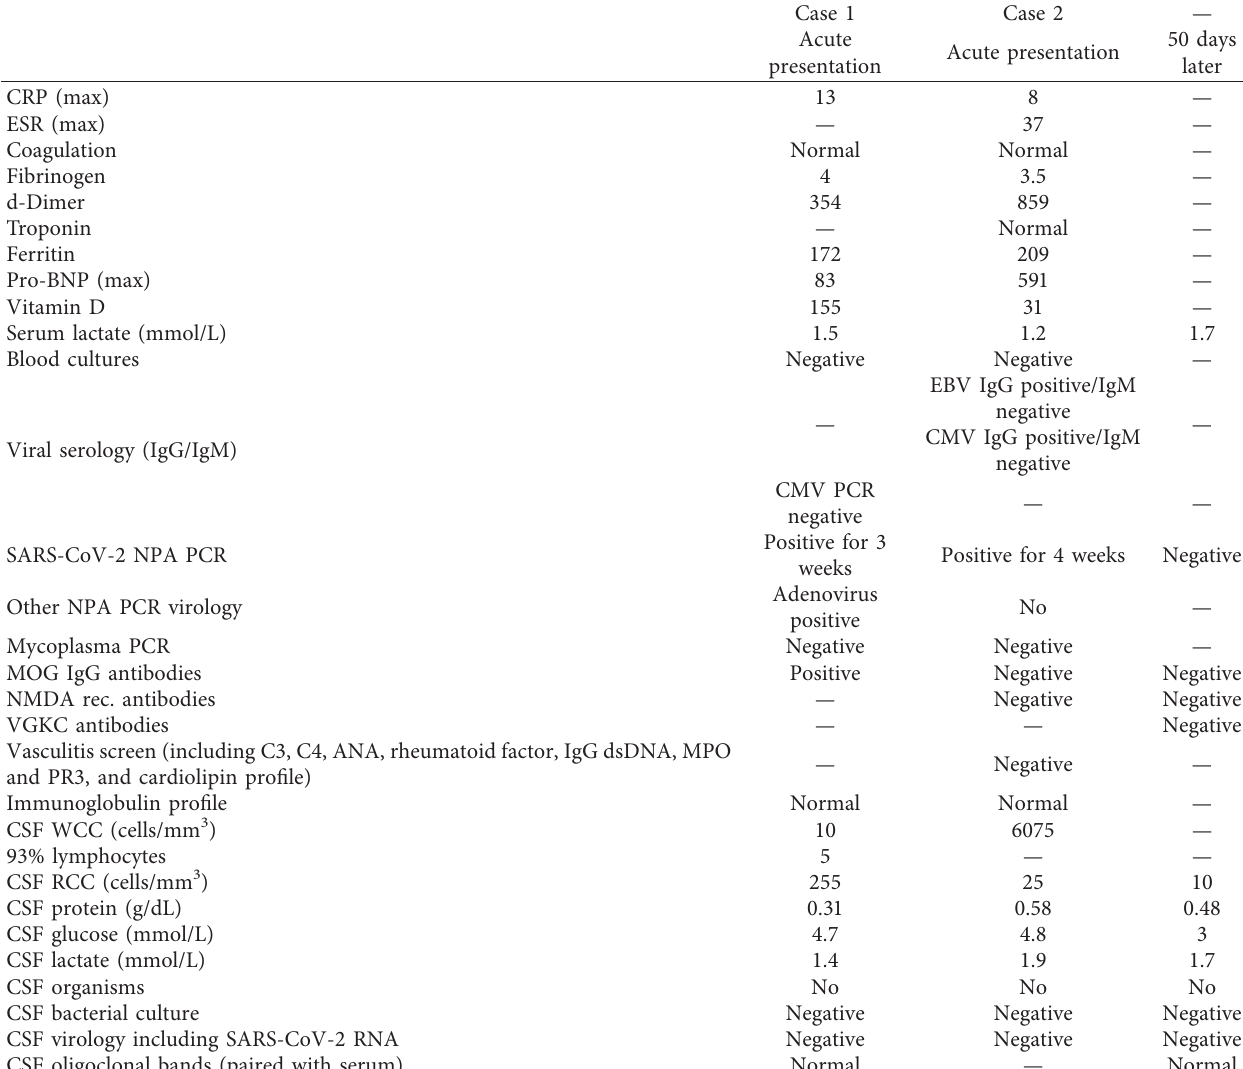
Table 1: Salient laboratory findings of presented